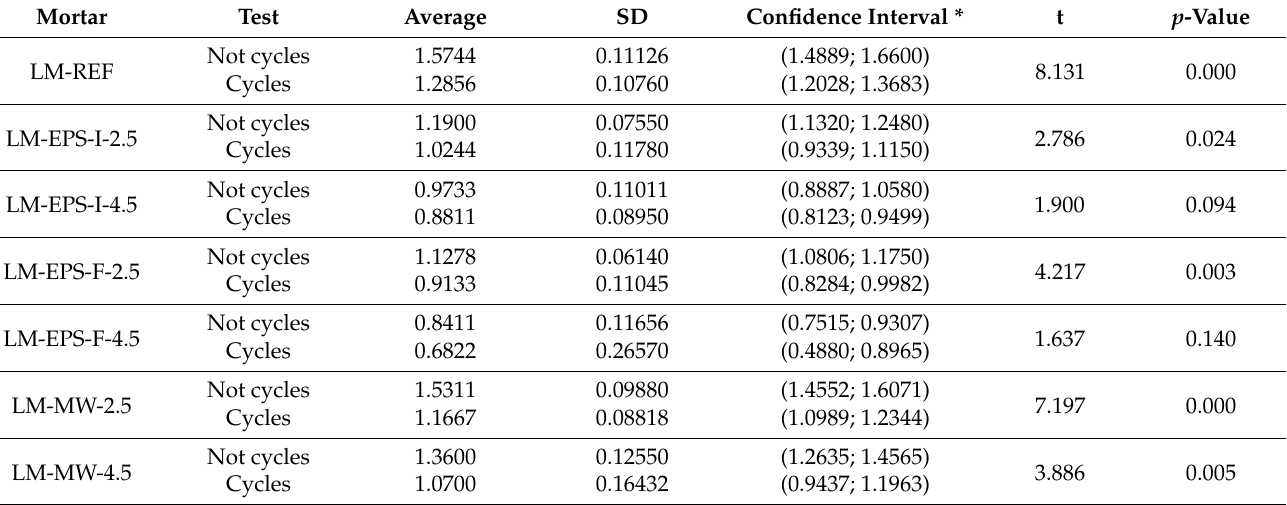
Table 20. Analysis for flexural strength in the salt crystallization test by Student’s t